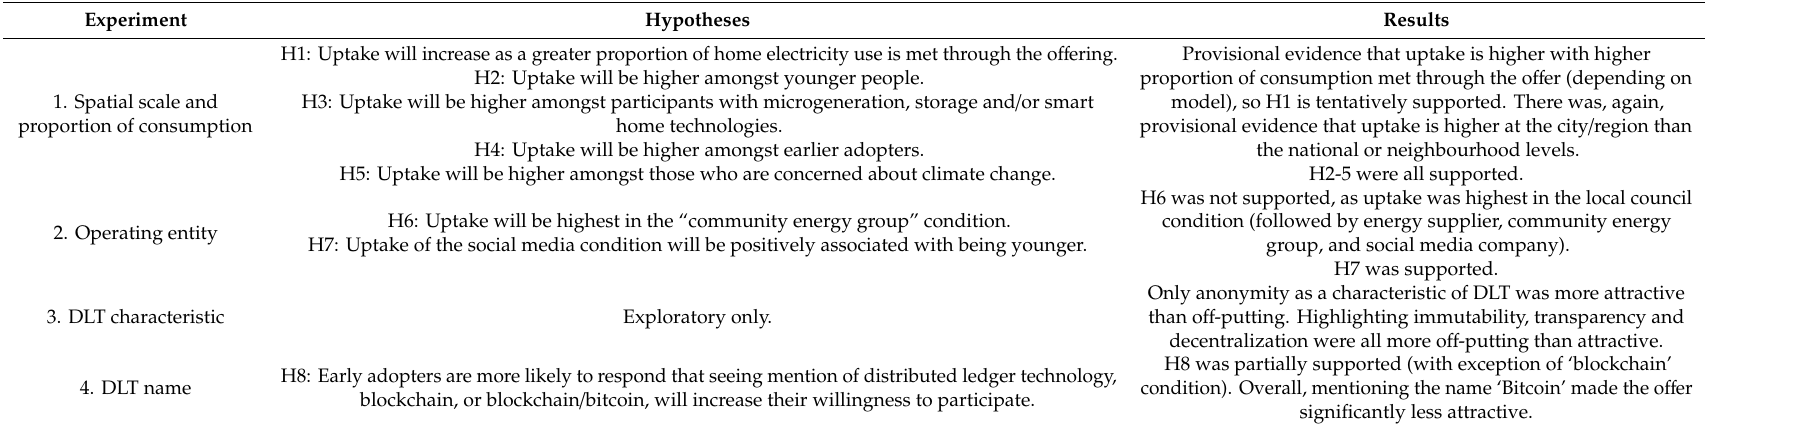
Table 7. Table of hypotheses and study